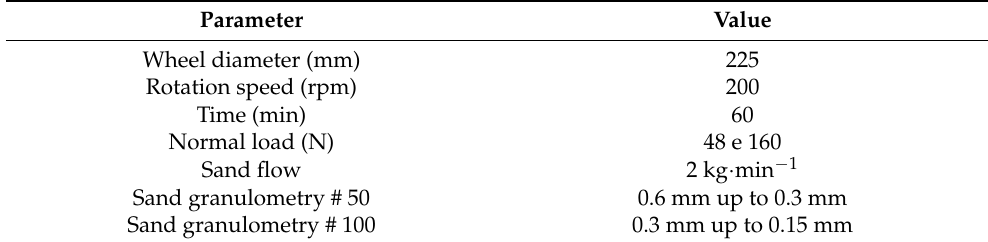
Table 3. Rubber wheel abrasion test